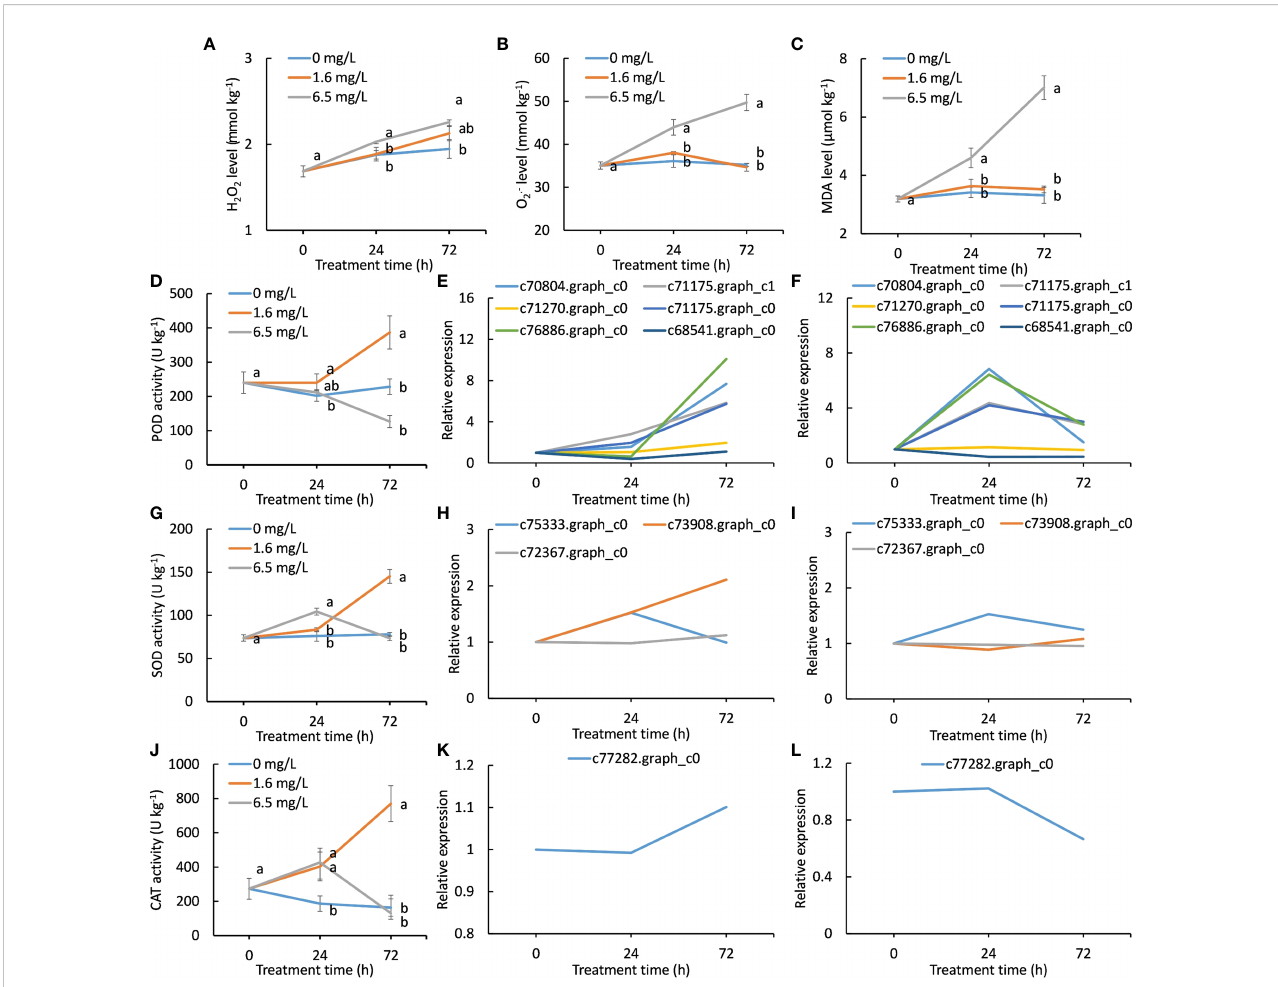
FIGURE 6 Changes of antioxidant activity and the expression patterns of DEGs encoding antioxidant enzymes during Cd exposure. (A) , hydrogen peroxide (H 2 O 2 ) contents of different Cd treatments in peppermint leaves; (B) , superoxide anion ( O 2 · − ) contents; (C) , malondialdehyde (MDA) contents; (D) , peroxidase (POD) activity; (E, F) , the expression patterns of DEGs encoding POD during low level of Cd treatment (1.6 mg L -1 ) and high level of Cd treatment (6.5 mg L -1 ), respectively; (G) , superoxide dismutase (SOD) activity; (H, I) , the expression patterns of DEGs encoding SOD during low level of Cd treatment (1.6 mg L -1 ) and high level of Cd treatment (6.5 mg L -1 ), respectively; (J) , catalase (CAT) activity; (K, L) , the expression patterns of DEG encoding CAT during low level of Cd treatment (1.6 mg L -1 ) and high level of Cd treatment (6.5 mg L -1 ), respectively. Each value is presented as means from three repeats. In fi gures (A-D, G, J) , statistical differences (p ≤ 0.05) between treatments are compared in the SPSS software and indicated using different letters above the